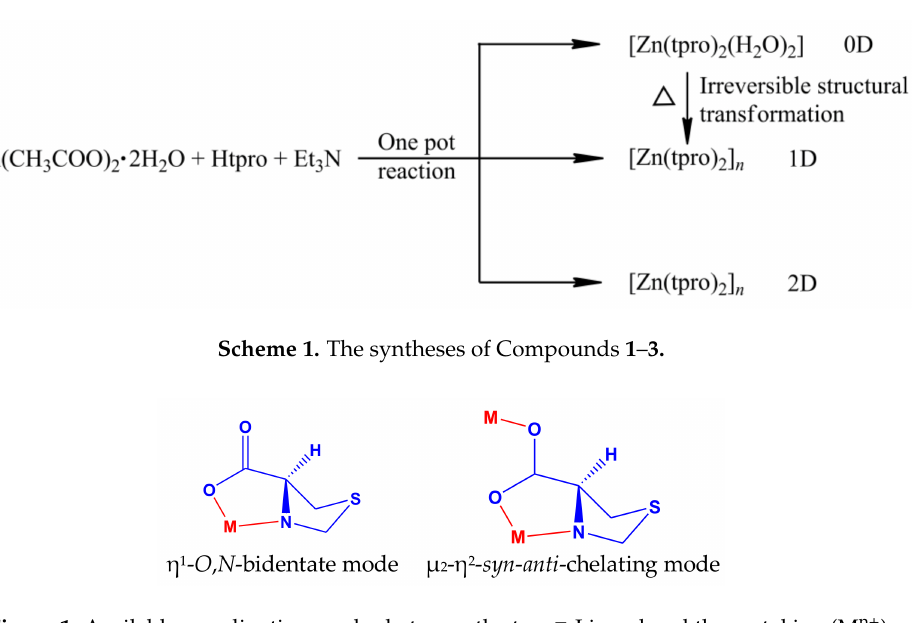
Figure 1. Available coordination modes between the tpro − Ligand and the metal ion (M n+